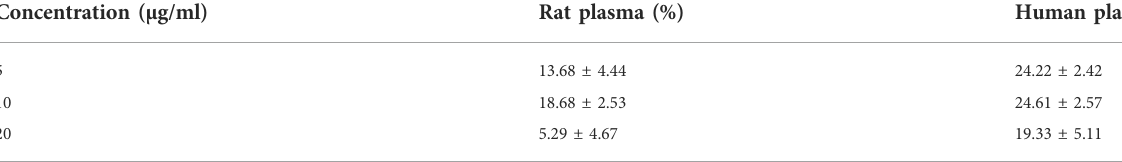
All glytrexate values are listed as the mean ± SD.